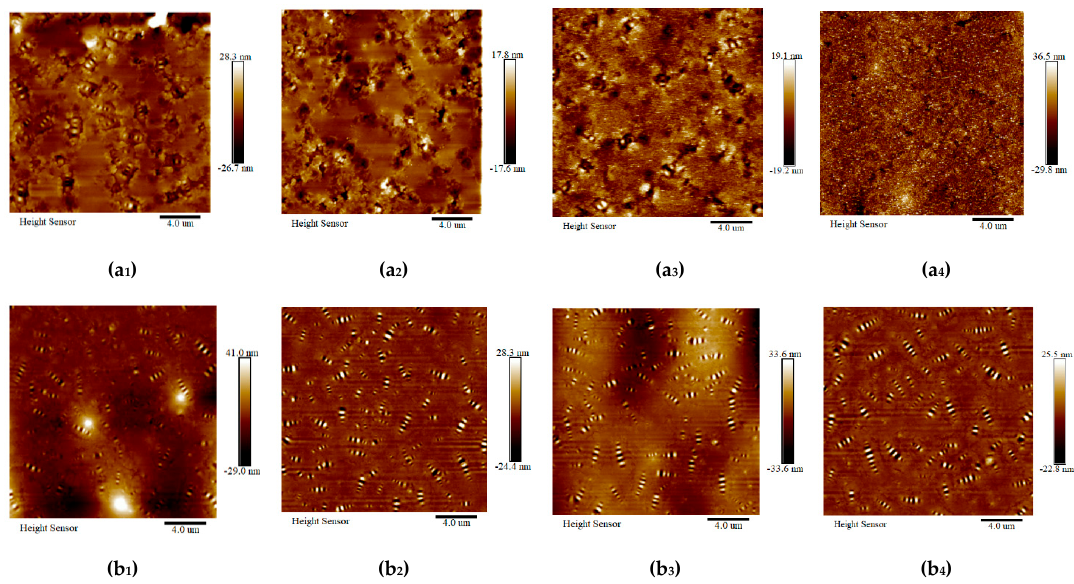
Figure 13. AFM topographic images of the mastics (20 × 20 µ m). ( a 1 ) Base mastics (0–0); ( a 2 ) Base mastics (8–8); ( a 3 ) Base mastics (15–8); and ( a 4 ) Base mastics (25–8). ( b 1 ) SBS-modified mastics (0–0); ( b 2 ) SBS-modified mastics (8–8); ( b 3 ) SBS-modified mastics (15–8); and ( b 4 ) SBS-modified mastics (25–8).